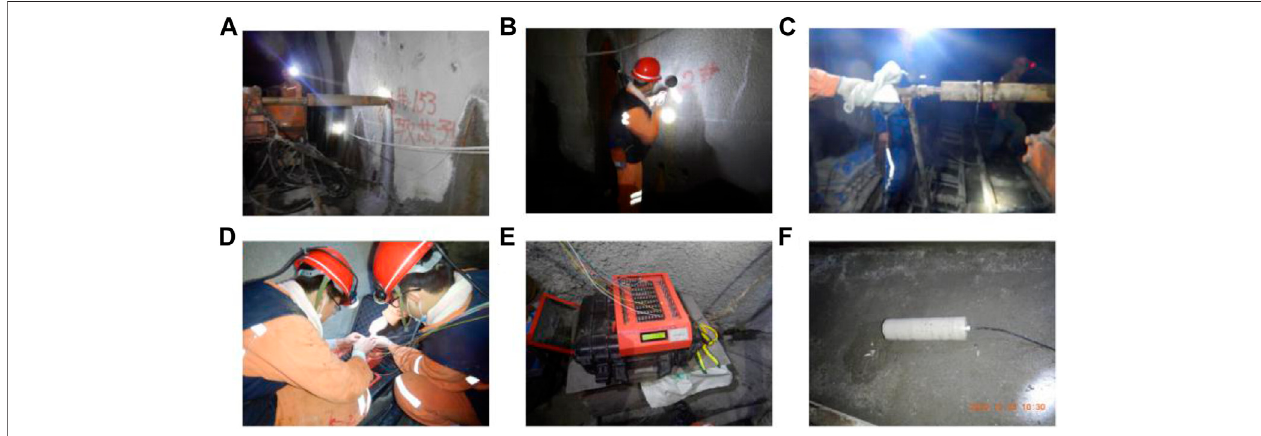
FIGURE 3 | Flow chart of the rock shear test. (A) Adjust the orientation of the drilling rig. (B) Start drilling test holes. (C) Install the hollow enclosure. (D) Relieve the stress of hollow inclusion. (E) Collect strain gauge data. (F) Core pulling.